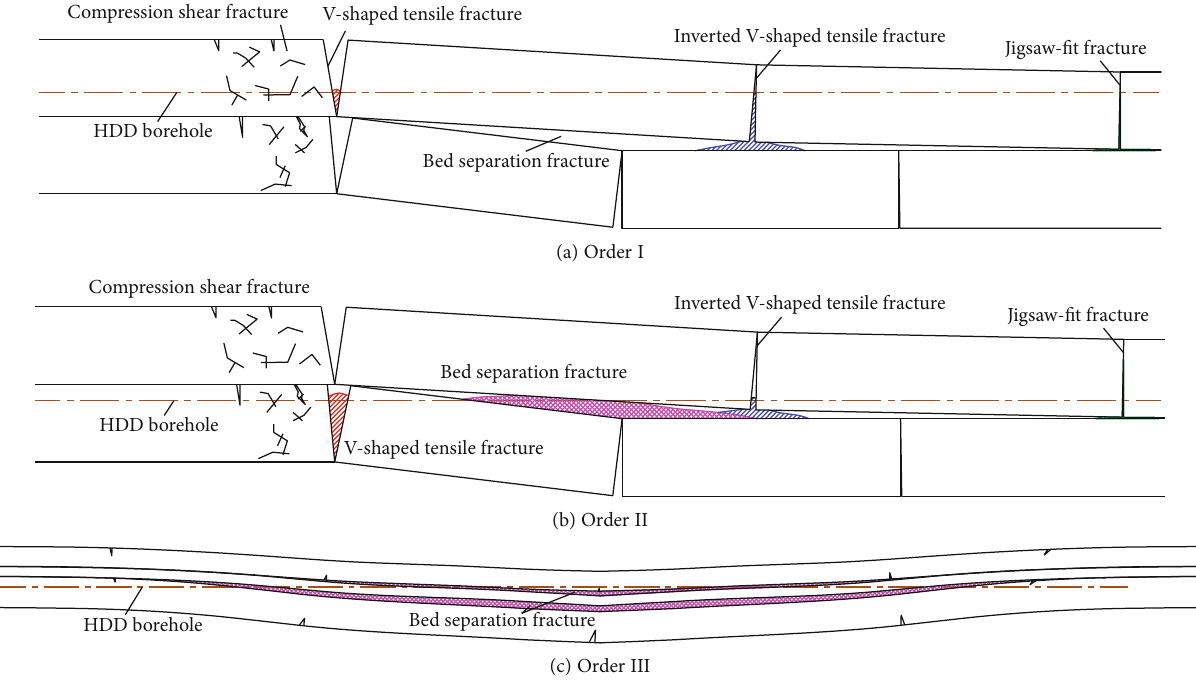
Figure 7: Types of fractures exposed by the HDD boreholes at di ff erent horizons.